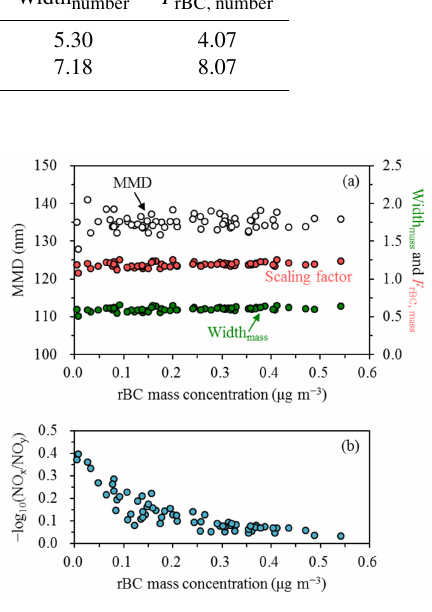
Figure 6. Dependences of (a) rBC MMD, mass distribution width (Width mass ) and mass-based scaling factor ( F rBC , mass ) , and (b) photochemical age on rBC concentration during F_8/26. Time resolution is 2min for all the parameters shown here. Based on the temporal variation of 2min averaged rBC mass concentration (Fig. S3), rBC ≤ 0.1µgm − 3 can be used as an indicator for typical out-of-plume conditions during F_8/26. Uncertainties introduced by lognormal fitting are within ± 5nm and ± 0.06 for the time- resolved MMD and Width mass ,